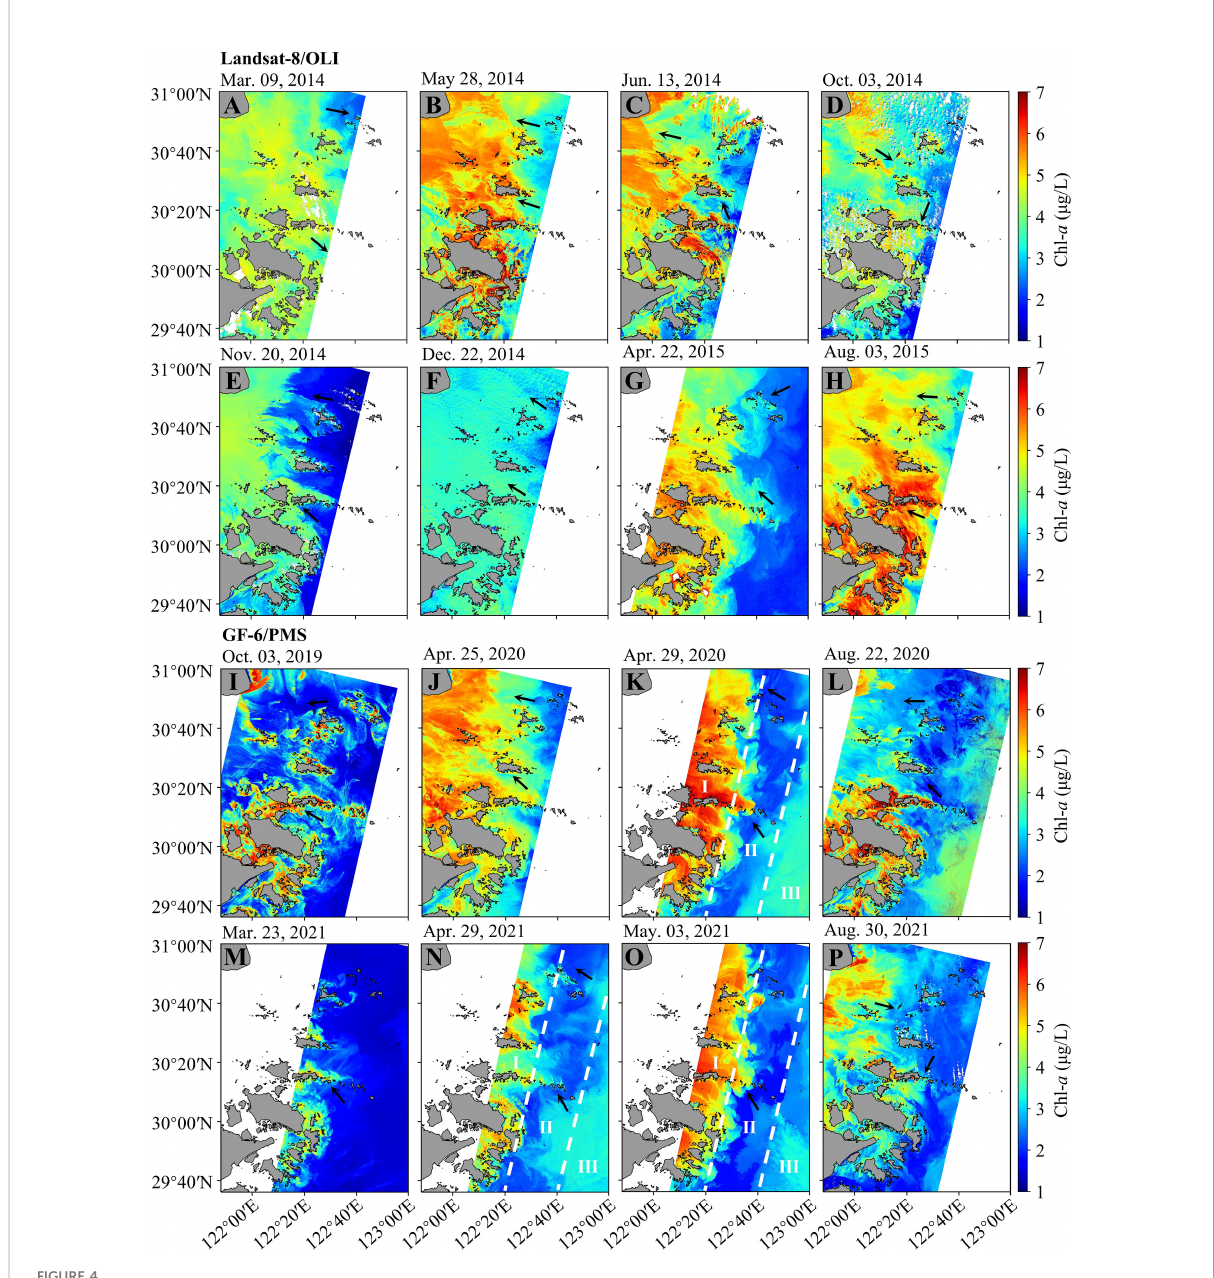
FIGURE 4 Distribution of Chl- a concentration in Zhoushan archipelago. (A-H) Chl- a obtained from Landsat-8/OLI; (I-P) Chl- a obtained from GF-6/PMS. Black arrow: the direction of the local current. Three regions I (the west of 122°30 ′ E), II (122°30 ′ E-122°50 ′ E), and III (122°50 ′ E-123°E) are delineated in (K, N, O)